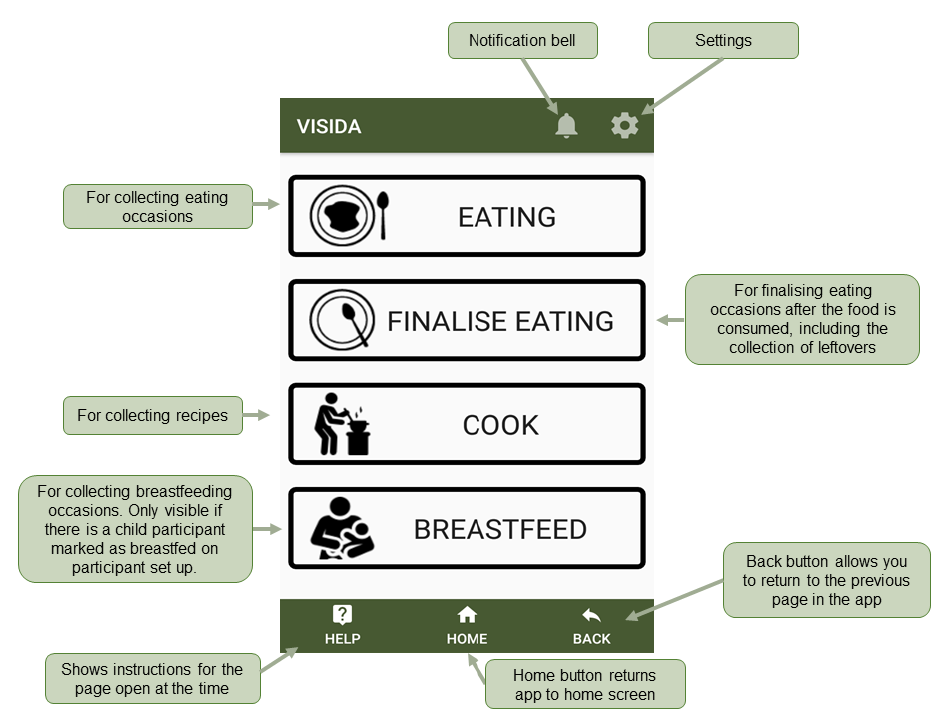
Figure 1. Main features of VISIDA app.